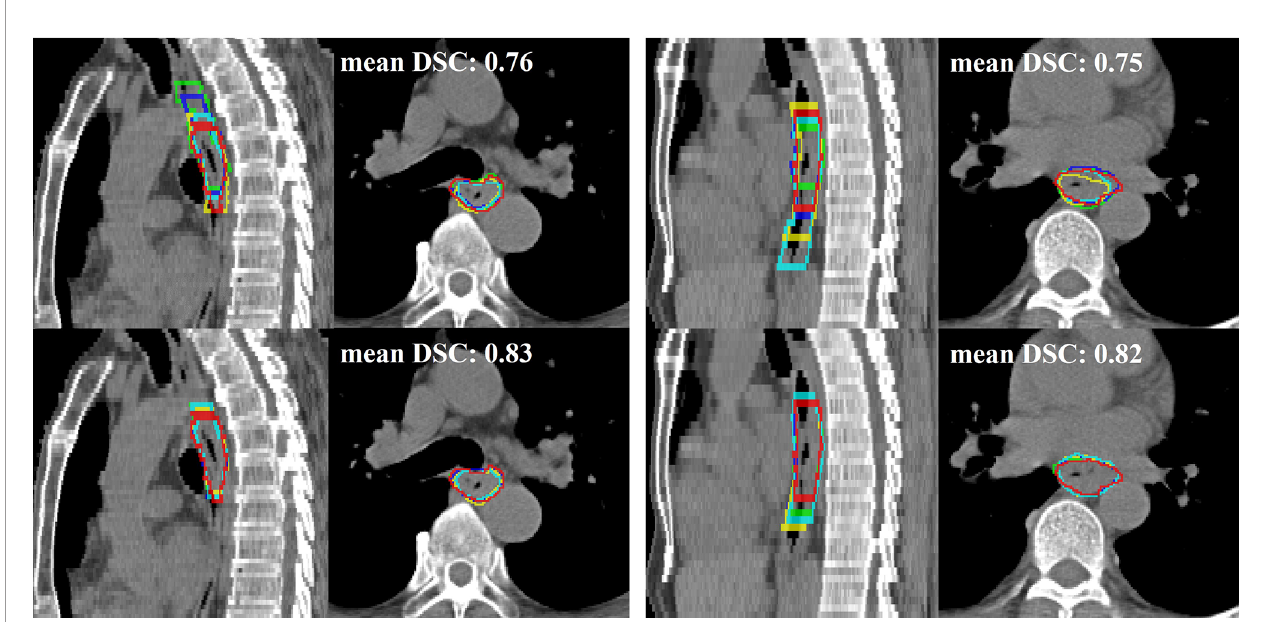
FIGURE 6 | Two qualitative examples (left and right) in sagittal and axial views of comparison between the fi rst-time manual contour (top row) and second-time deep learning-assisted contours (bottom row). Red is the ground truth contour, while green, blue, yellow, and cyan represent the other four radiation oncologists ’ contours. The average Dice similarity coef fi cient (DSC) of 4 radiation oncologists for their fi rst-time manual contour is 0.76 and 0.75 to the two examples, respectively. The DSC performance improved to 0.83 and 0.82 for their second-time contour with assistance from the deep learning